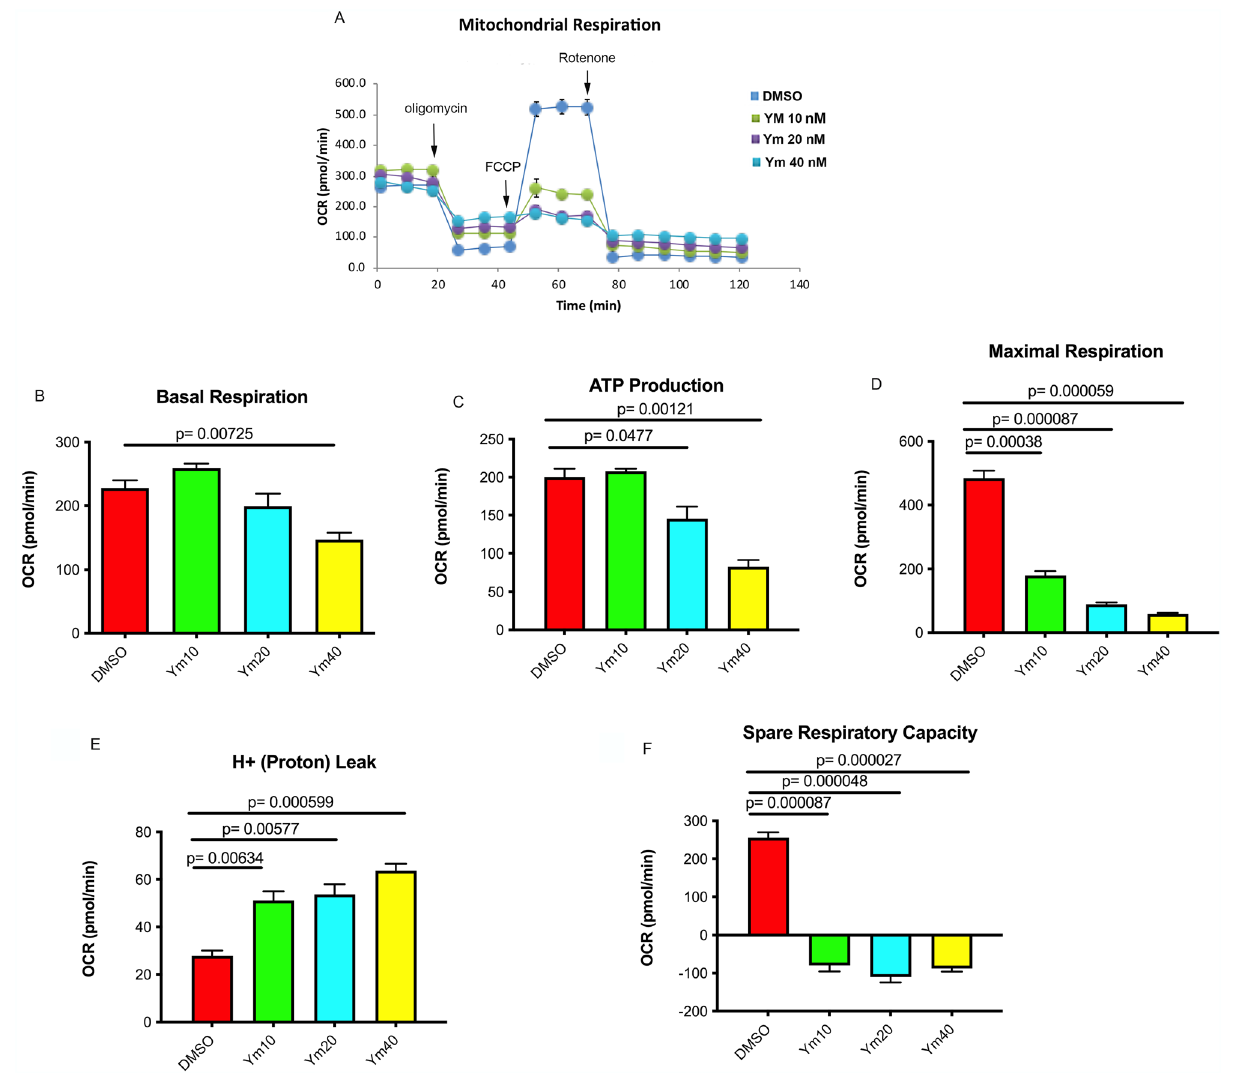
for 3 h. Inhibitors of ETC oligomycin (complex V), FCCP (uncoupler), Rotenone (complex I) were used to interrogate oxidative phosphorylation. ( A ) OCR curves of H1299 cells treated with Ym155. ( B ) Mean basal respiration, ( C ) ATP production, ( D ) maximal respiration, ( E ) proton leak, and ( F ) spare capacity from 3